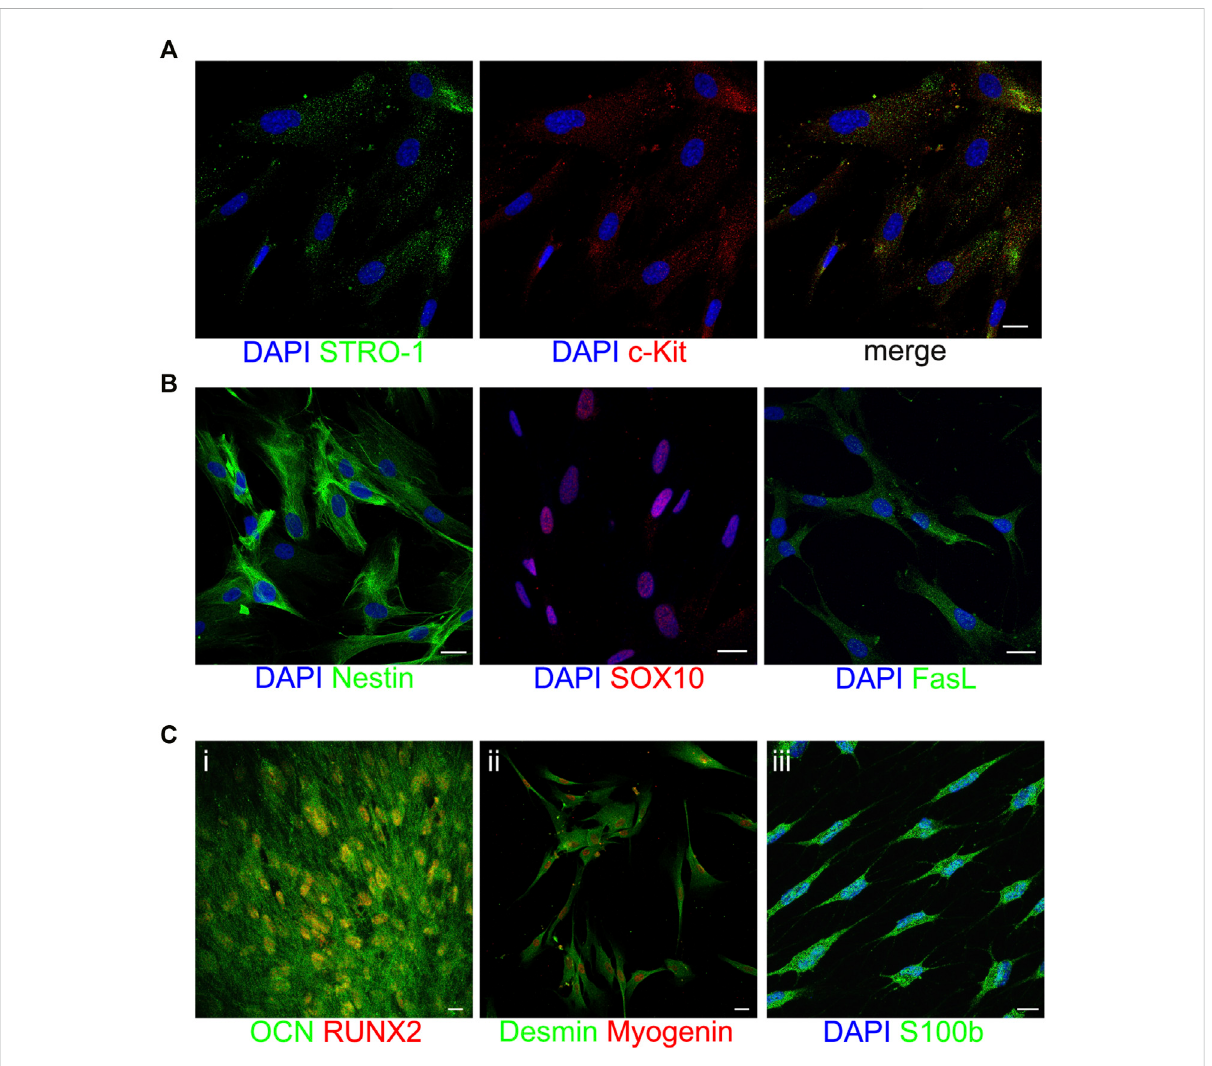
(Figure 2C_iii) lineages, as shown by the positive immunolabeling against the lineage speci fi c